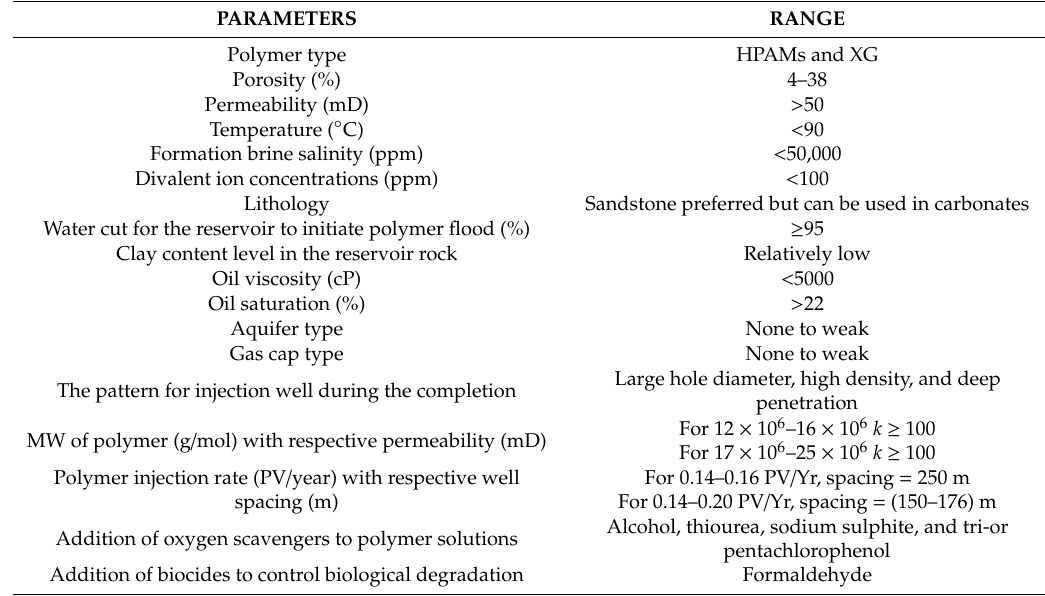
Table 5. Summary conditions for e ff ective XG and HPAM field applications. This data set was obtained from the study by [64,65] with additional modification from